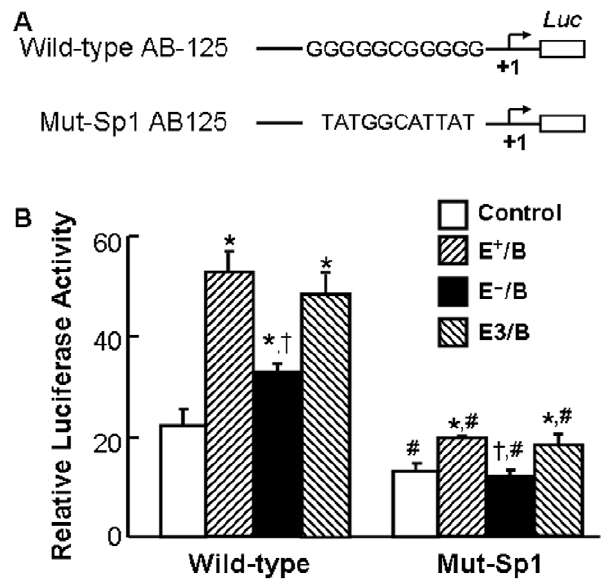
Figure 2. The effect of ApoE on lipoprotein-induced ABCA1 promoter activity. Pane A: Two constructs containing wild-type and Sp1-binding site-mutated (Mut-Sp1) ABCA1 promoter region were subcloned into a luciferase (Luc) reporter plasmid (pGL-2). The mutated sequences in the Mut-Sp1 construct are shown in the schematic diagram. Panel B: Mouse macrophages were transfected with a b - galactosidase expression plasmid and the ABCA1 promoter-reporter constructs or the empty pGL-2 vector. The transfected macrophages were treated with 20 m g/ml of wild-type (E + /B), ApoE-free (EIˆ/B) or ApoE3-enriched (E3/B) lipoproteins, or culture medium alone (control) for 4 hrs. Luciferase activity was normalized to the b -galactosidase activity and expressed relative to that of pGL2 basic vector. Values represent the mean 6 SEM of five independent experiments. * P , 0.05 compared to cells transfected with the same plasmid and without lipoprotein treatment (control), { P , 0.05 compared to cells transfected with the same plasmid and treated with E + /B or E3/B lipoproteins, and # P , 0.05 compared to cells transfected with wild-type ABCA1 promoter and treated with the same lipoproteins.